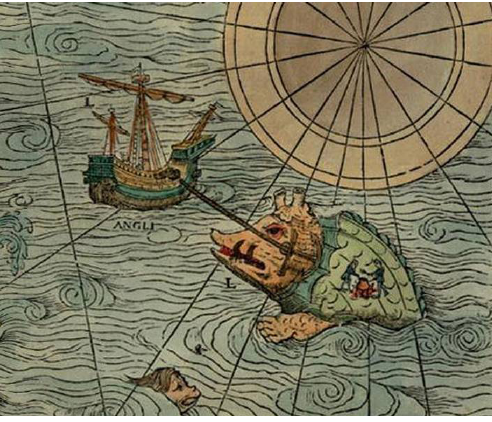
Figure 2. Carta Marina 1539 by Olao Magno (1490–1557), particular.